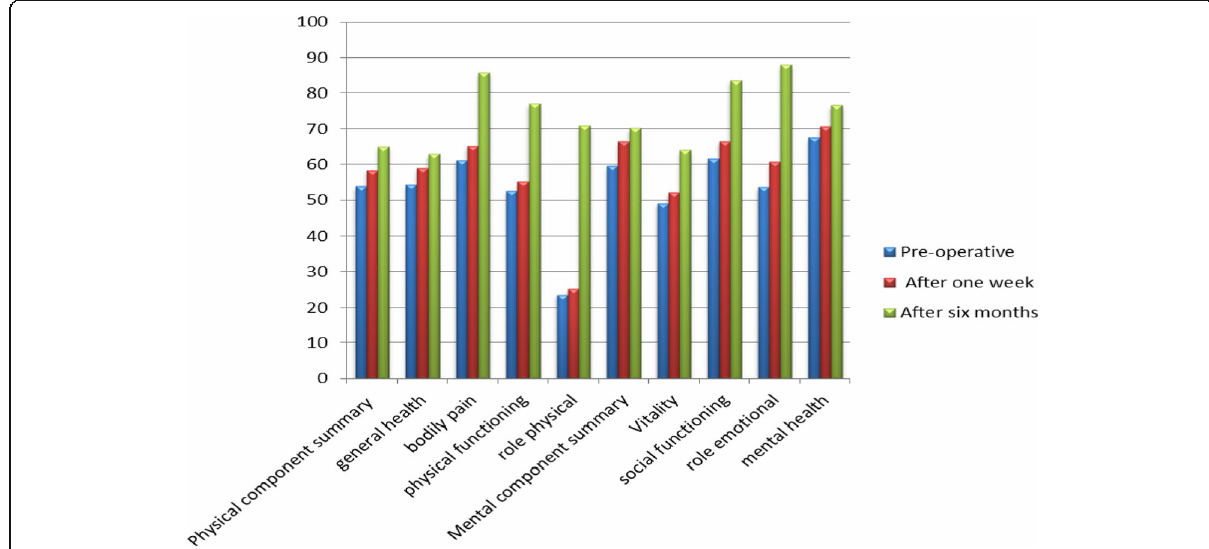
Fig. 1 Mental and physical components of the SF-36 questionnaire in the studied patients at different point times